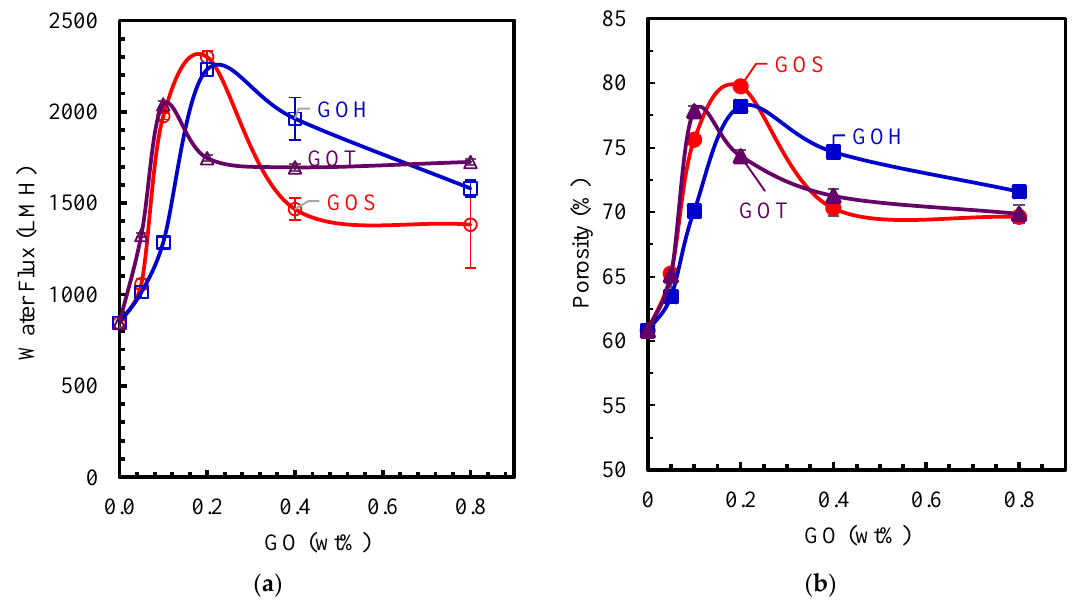
Figure 6. Pure water flux at 2 bar ( a ) and porosity ( b ) of GO modified membranes. Error bars show sample standard deviation.